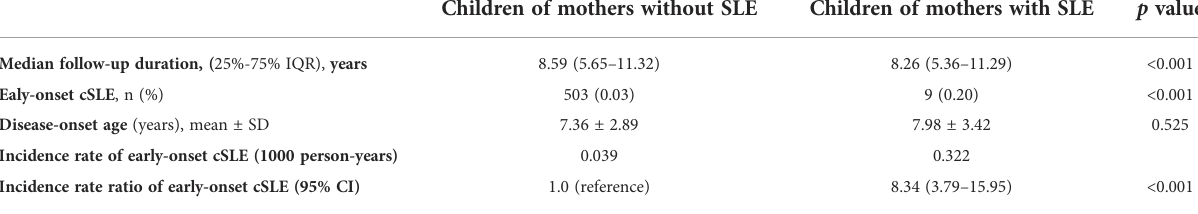
TABLE 2 Outcomes of offspring of women with SLE compared with those of women without